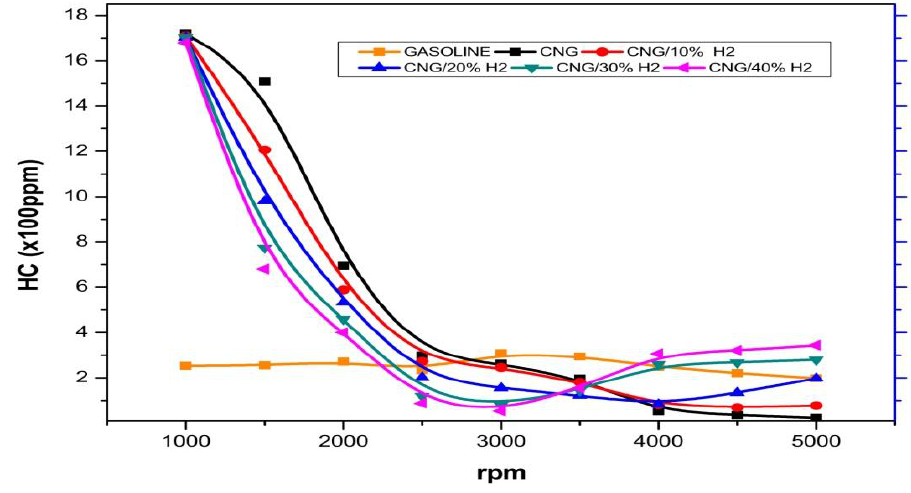
Figure 17. HC concentration in function of engine speed.